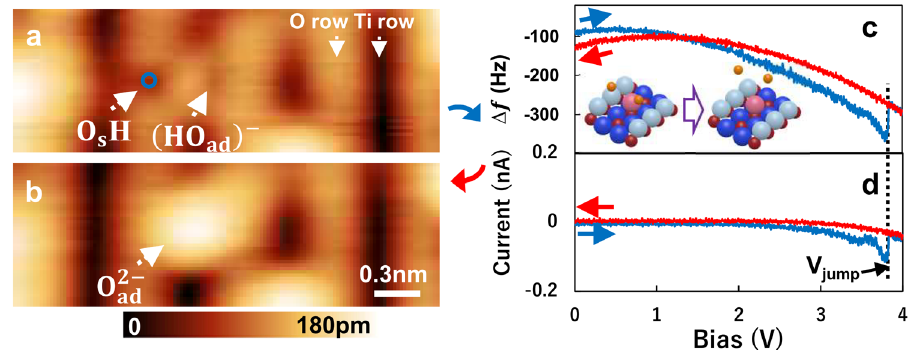
Fig. 3 Positive sample bias applied to the O s H − (O ad H) − − O s . a , b AFM images before ( a ) and after ( b ) KPFS manipulation of O s H − (O ad H) − − O s . Imaging parameters for ( a , b ): constant Δ f mode, V bias = 0 V and 1.0 × 3.0 nm 2 . c , d Results of KPFS and tunneling current applied in a . The feedback loop was switched off during the measurements, and the sample bias was ramped from zero to a certain positive voltage and then ramped back to zero. The blue and red lines show the forward and backward directions, respectively. The tip position is indicated by a blue circle in (a). The black dotted line serves as a guide for the eye for the V bias = V jump .